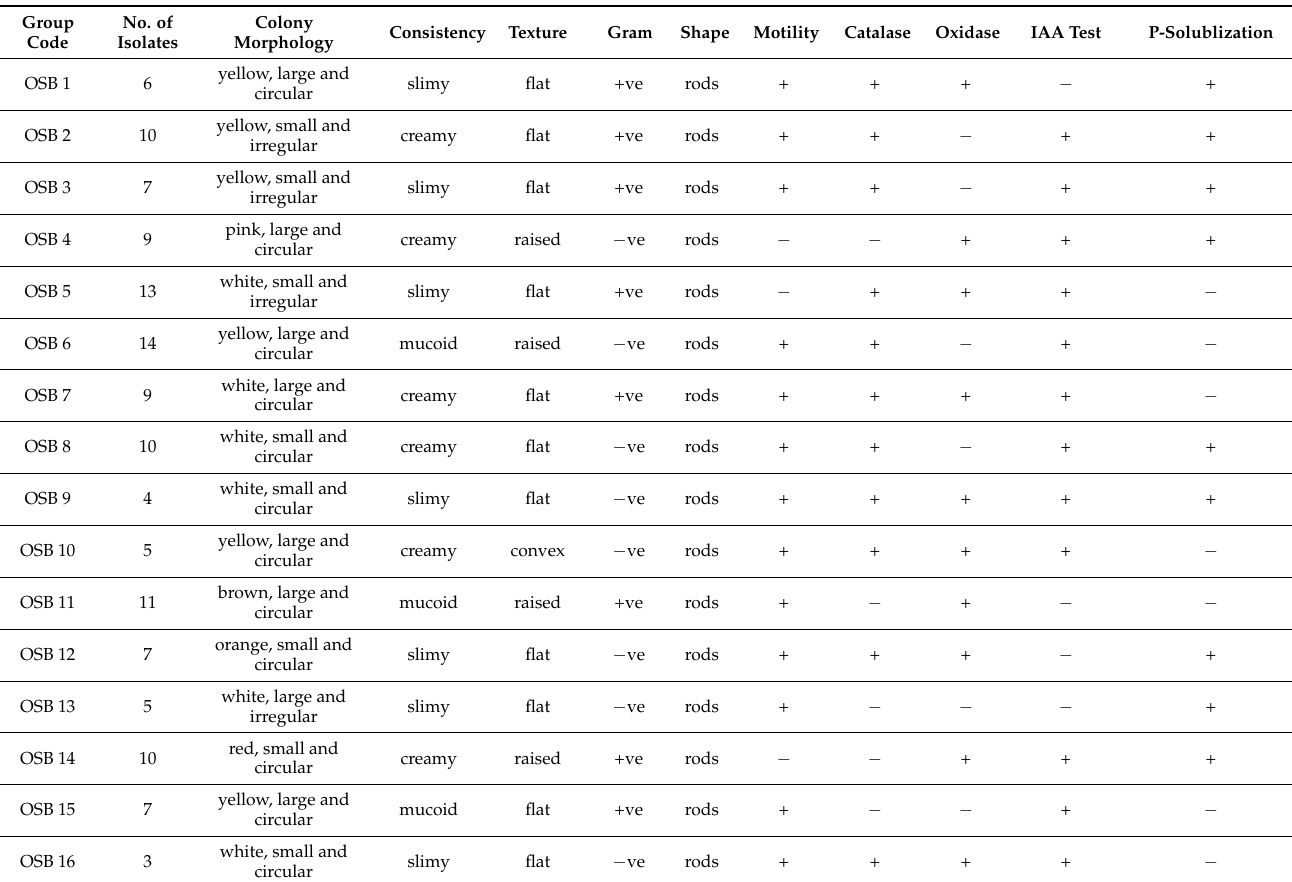
Table 1. Clustering of the obtained bacterial isolates from olive varieties based on common morpho- logical and biochemical